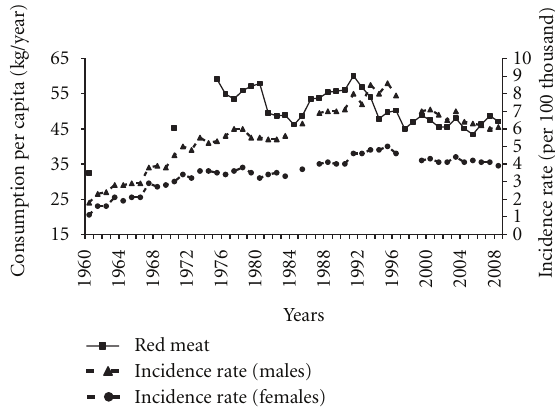
Figure 4: Cholesterol intake and pancreatic cancer morbidity 1960– 2008.